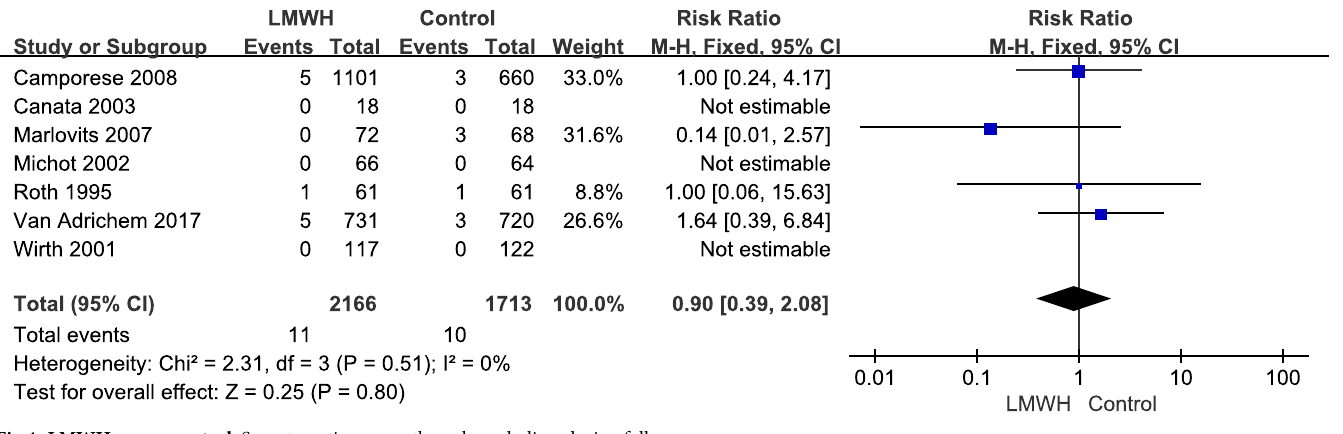
Fig 4. LMWH versus control. Symptomatic venous thromboembolism during follow-up.